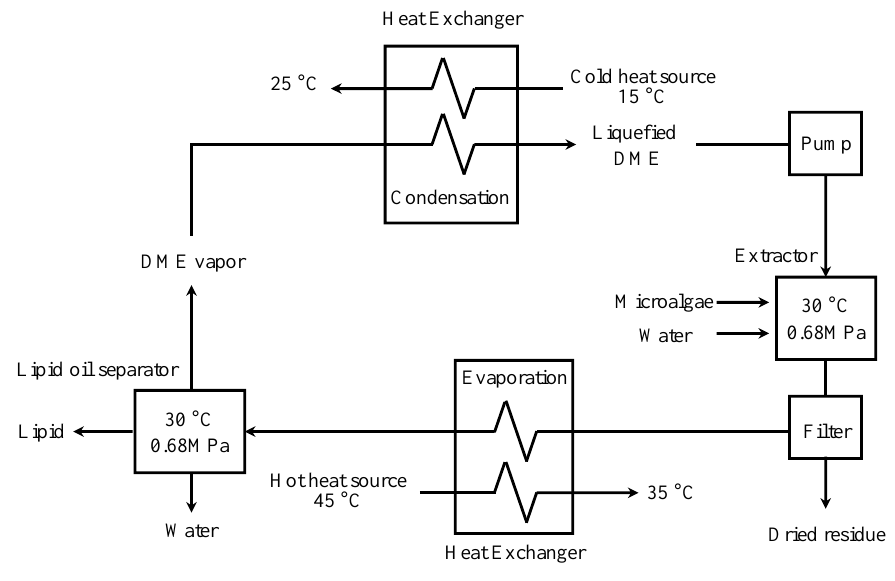
Figure 4. Process concept of energy-saving extraction by liquefied